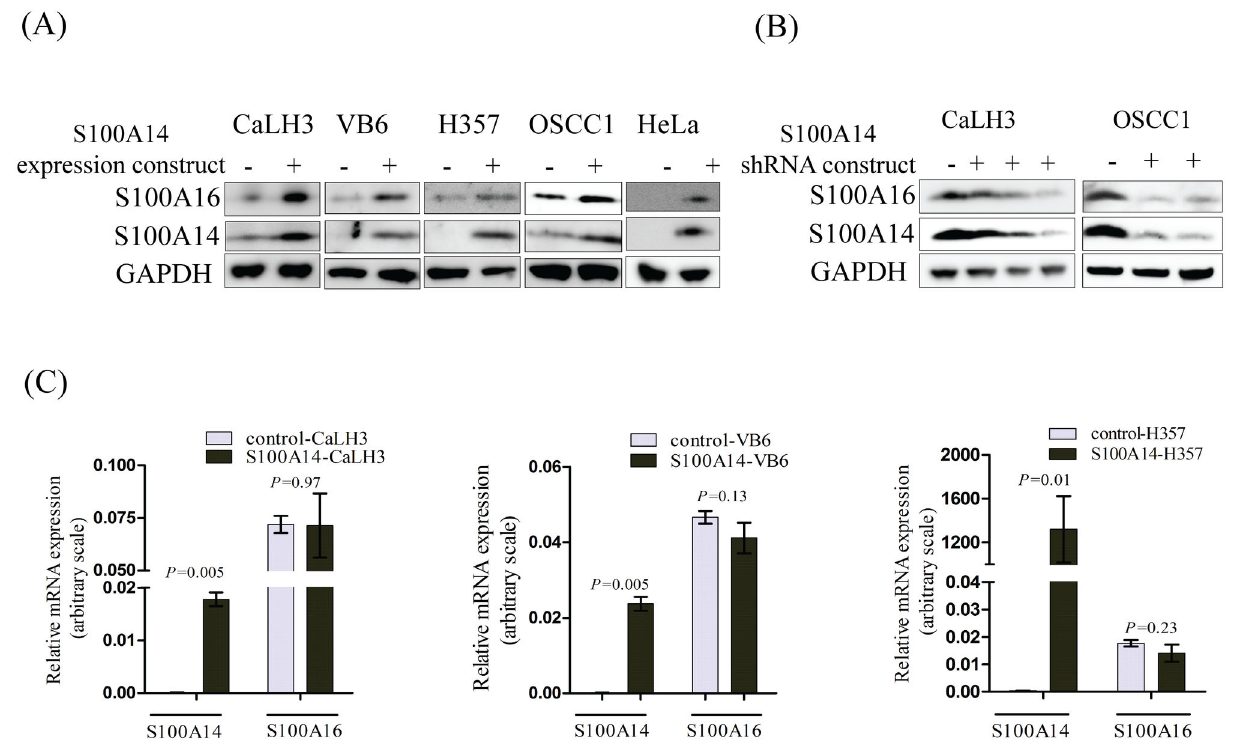
Figure 3. Over-expression of S100A14 modulates expression of S100A16 protein but not mRNA in human cancer cell- lines. (A) Retroviral mediated over-expression of S100A14 was associated with concomitant up-regulation of S100A16 protein in CaLH3, VB6, H357, OSCC1 and HeLa cell-lines (-, control construct; +, S100A14 expression construct). (B) Additionally, shRNA mediated knock-down of S100A14 in CaLH3 and OSCC1 cell-lines was associated with down-regulation of S100A16 protein (-, control construct; +, S100A14 shRNA constructs). (C) However, there was no effect in the mRNA expression levels of S100A16 by over-expressing S100A14 in CaLH3, VB6, and H357 cell-lines. S100A14 and S100A16 mRNA expression levels were normalized to GAPDH mRNA expression. Error bars represent SEM of 3 biological replicates done in 3 technical replicates. Student’s- t test (paired) was performed for statistical